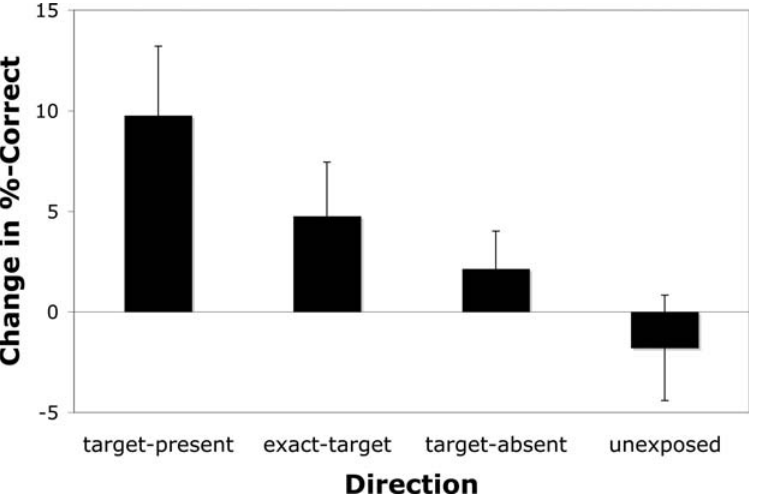
Figure 2. Performance change on the direction discrimination task, between pre- and post tests. Unexposed directions data represent the average across the 3 directions that were not exposed during the training phase. Error bars represent within-subject standard error [20]; see methods for details.